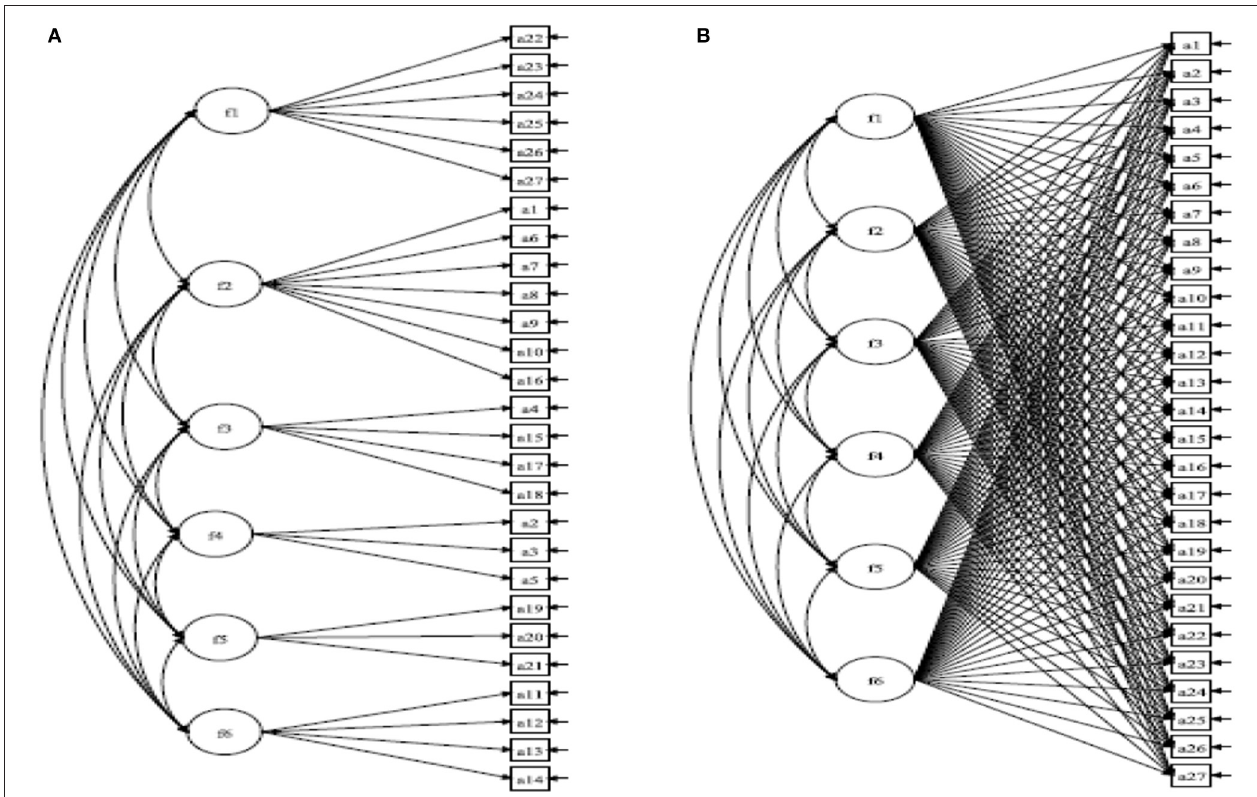
FIGURE 1 | (A) Confirmatory factor analysis (CFA), and (B) exploratory structural equation (ESEM) modeling.